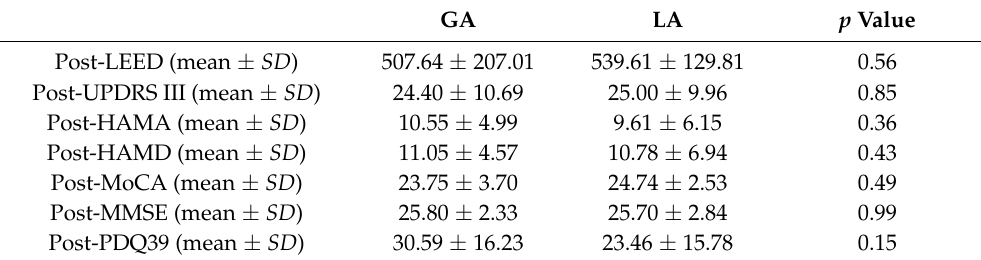
Table 3. Comparison of the prognosis between the two groups after six months .